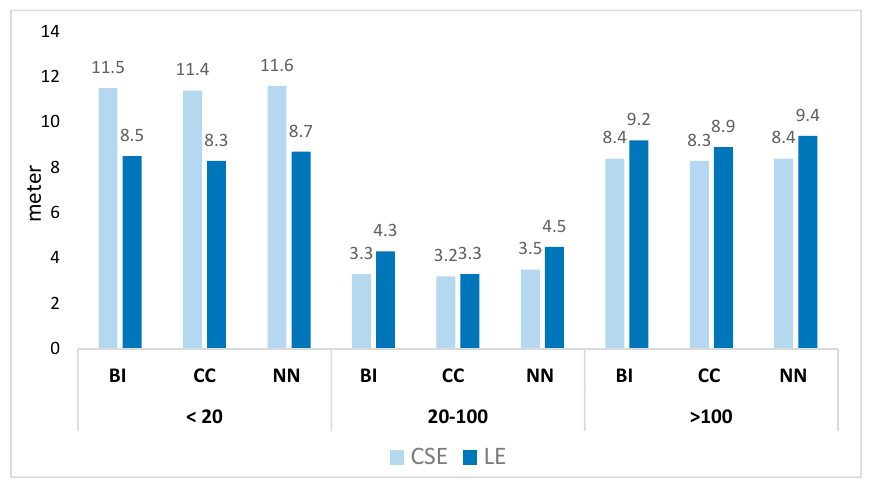
Figure 5. Variation of circular standard (CSE) and linear error (LE) metrics for different numbers of GCP classes.